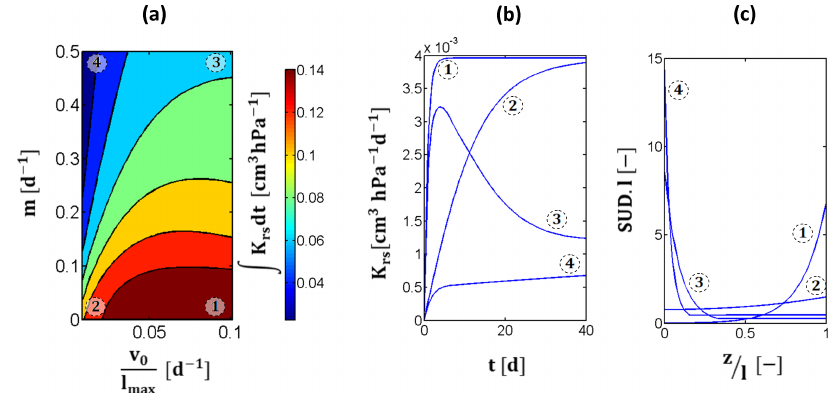
Figure 12. Integral of the effective root conductance over time when changing the elongation rate v 0 ( y axis) (a) . Root hydraulic conductances of the four extreme cases numbered and indicated in (a) as a function of time (b) . Relative uptake of the four single roots after 20 days as a function of the relative position to the root tip ( l is the root length and z = 0 at the tip) (c) .